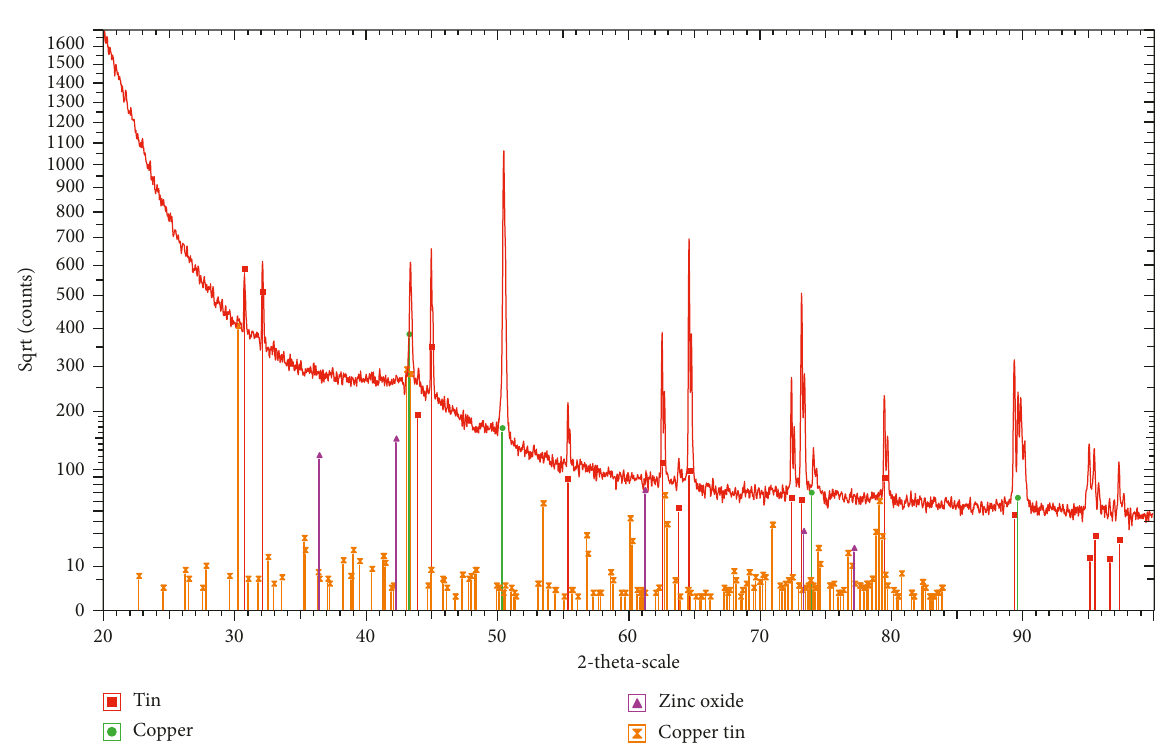
Figure 13: The XRD pattern of